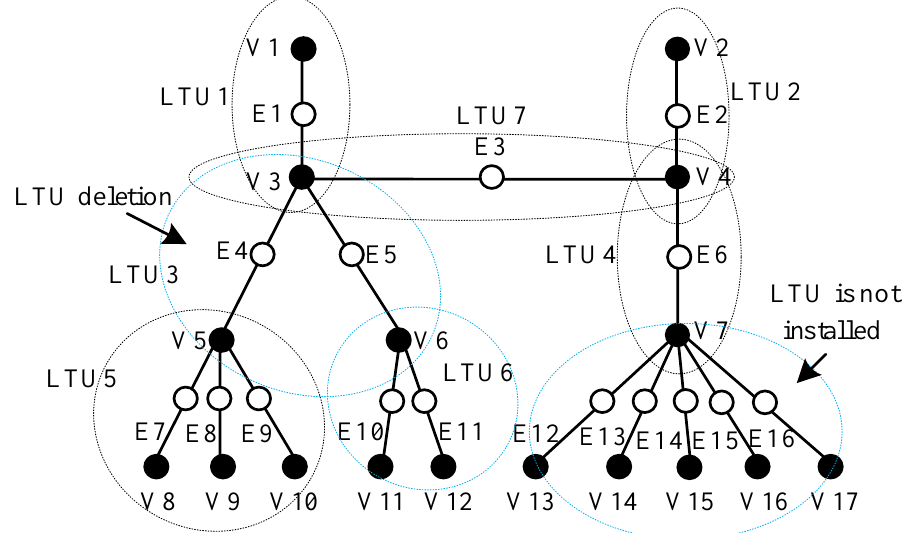
Figure 6. Topological region partitioning sub-model diagram.